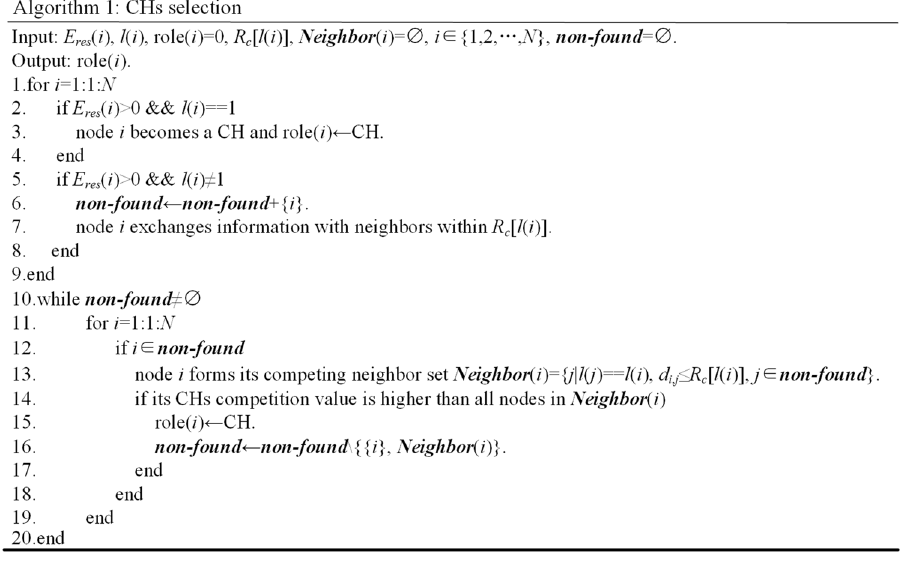
Figure 3. Pseudo code for CHs